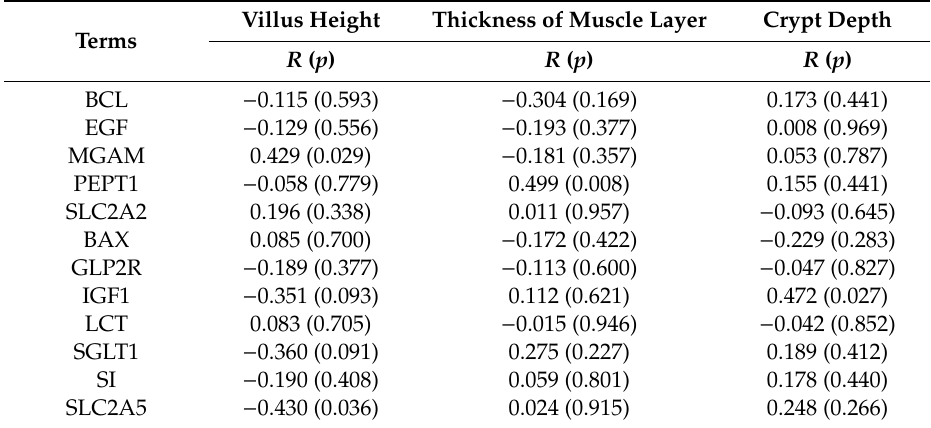
Table 6. Correlation analysis of genes and phenotypes in the jejuna of newborn lambs supplemented with folic acid during maternal